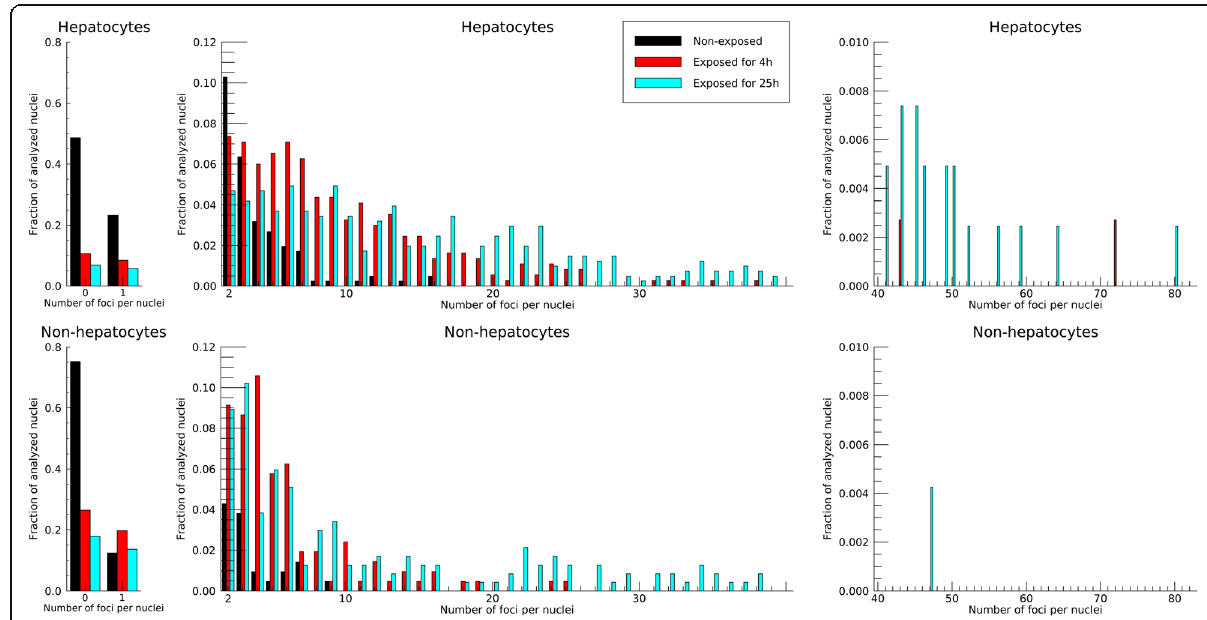
Fig. 4 Histograms showing the fraction of analyzed nuclei containing a certain number of γ -H2AX foci for the three different groups of animals: non-exposed (black), exposed for 4 h (red), and exposed for 25 h (cyan). Note that the x -axis is continuous over the three horizontal sub-pictures, but splitted up with respect to the varying scale of the y